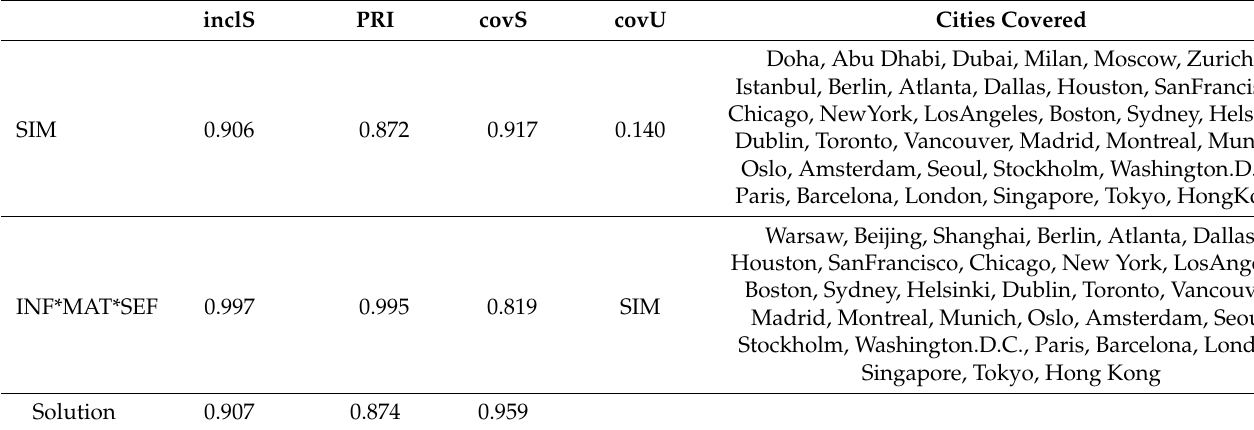
Table 3. Enhanced intermediate solution OVE.